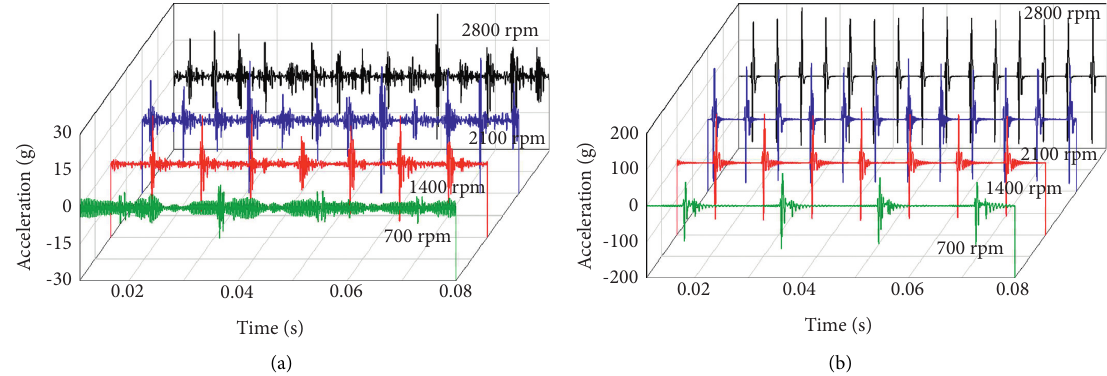
Figure 12: Acceleration signals under different speeds at different points: (a) the measurement point #1 and (b) the defect point